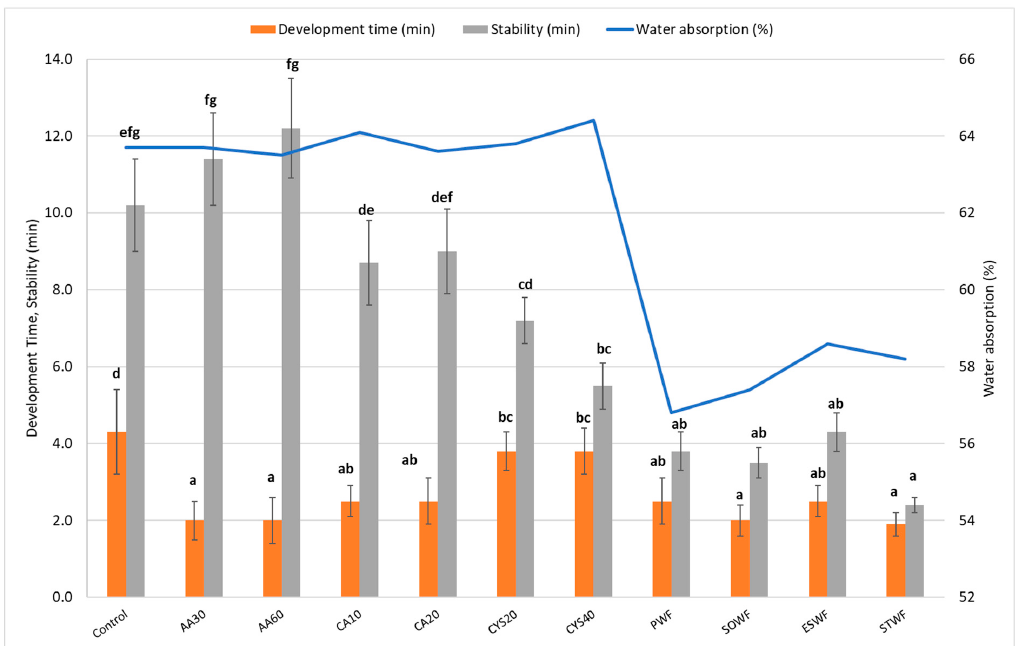
Figure 2. Variation of dough development time, stability and water absorption of flours and control flour with added improvers (Ascorbic acid: AA30, AA60, Citric acid: CA10, CA20, L -Cysteine CYS20, CYS40). Similar letters indicate no statistical difference for each particular characteristic of the various dough samples (ANOVA with Tukey’s HSD multiple comparisons, p <